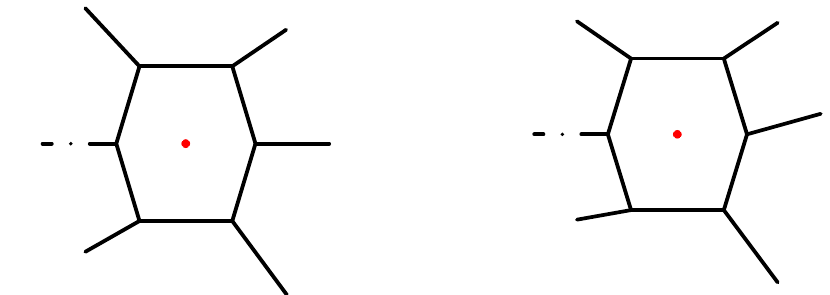
Figure 9. Initial attitude of leg 1 fault.